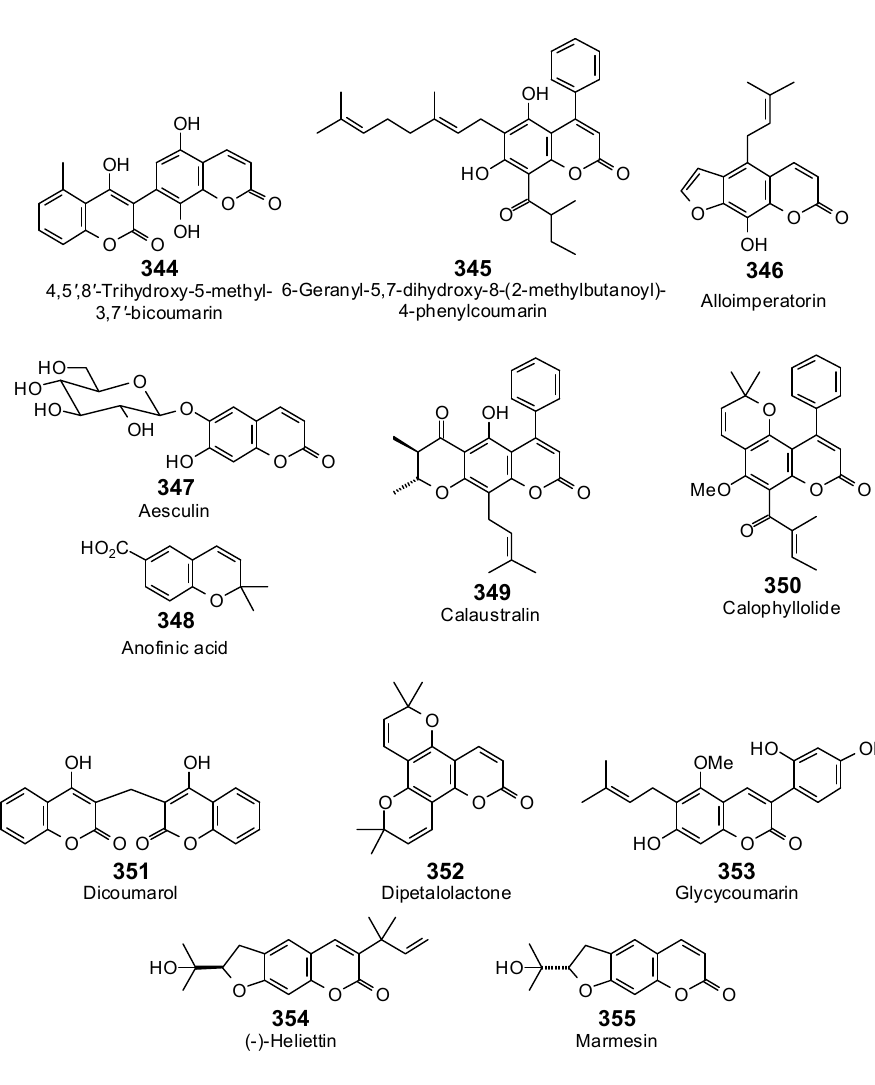
Figure 13. Coumarins examined in this work.